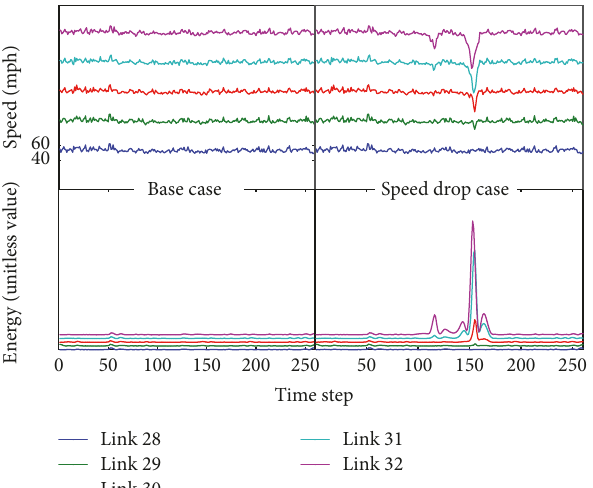
Figure 5: A comparison of speed and corresponding energy under Scenarios 1 and 2.